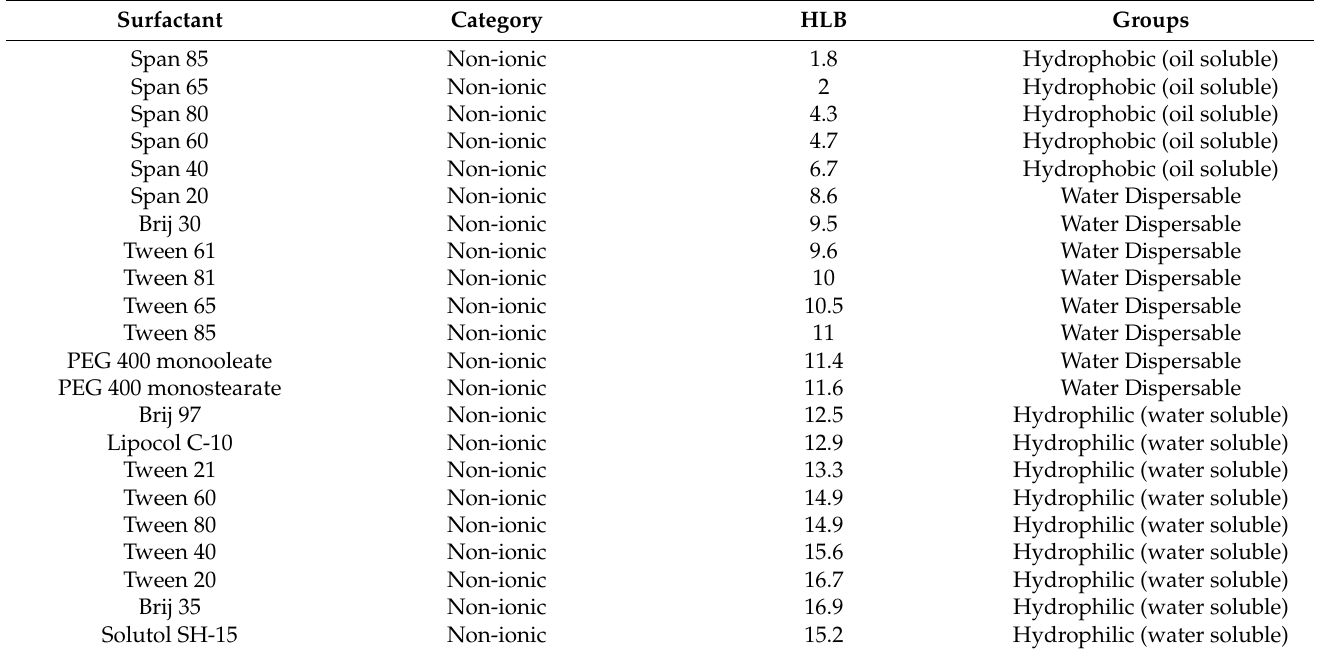
Table 1. Surfactants mostly used in drug